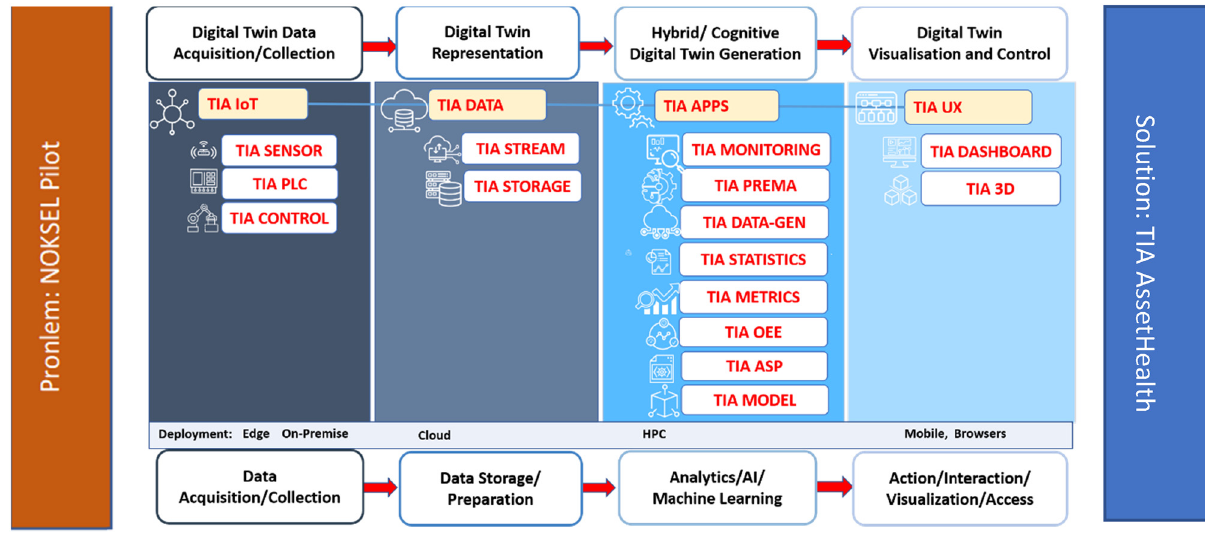
Figure 6: The cognitive digital twin developed and deployed for the NOKSEL pilot.